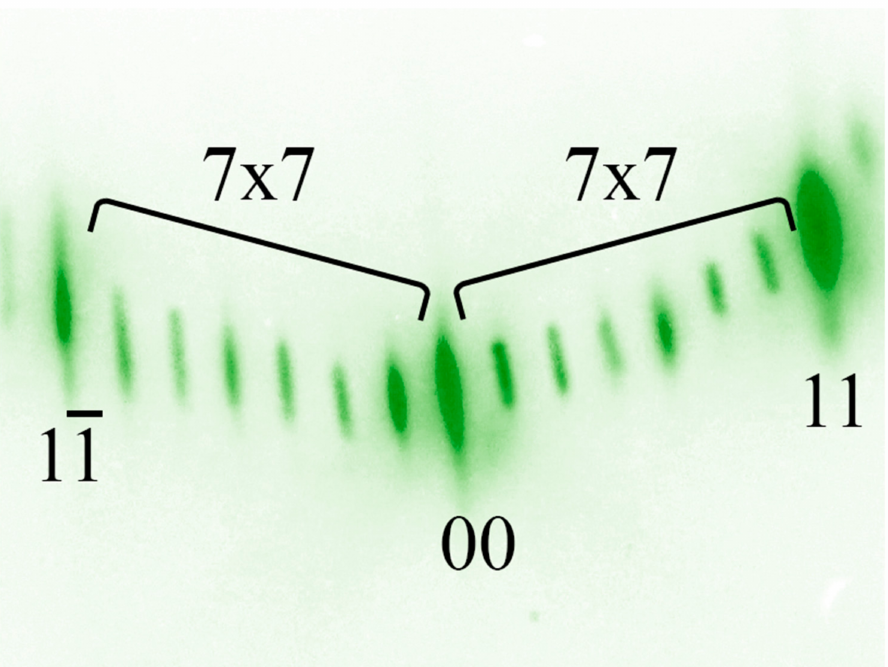
Figure 3. Diffraction pattern from the germanium layer on Si(111) with the 7 × 7 reconstruction at the initial stage of